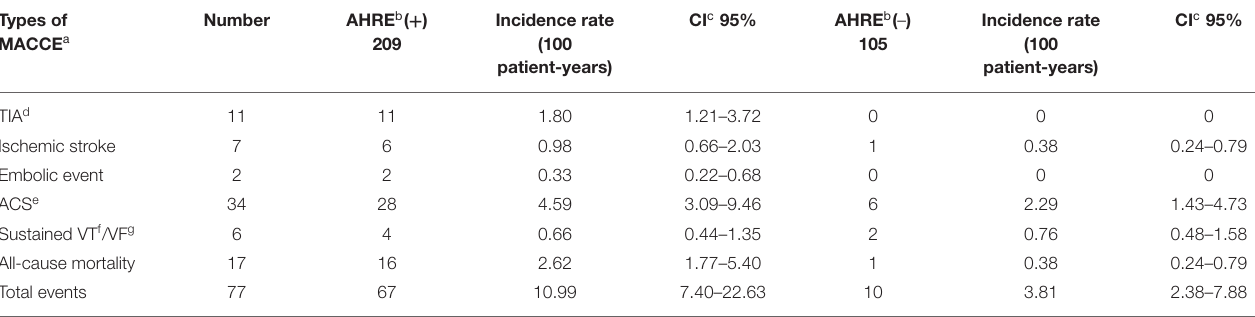
TABLE 2 | Types and incidences of major adverse cardio/cerebrovascular events in patients with or without AHRE.